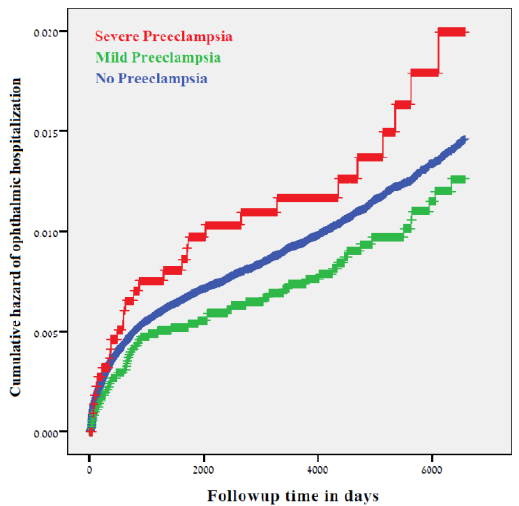
Figure 2. A Kaplan–Meier curve demonstrating the cumulative incidence of long-term ophthalmic Figure 2. A Kaplan – Meier curve demonstrating the cumulative incidence of long-term ophthalmic morbidity in o ff spring exposed to preeclampsia (Log-rank test, p = morbidity in offspring exposed to preeclampsia (Log-rank test, p = 0.118).